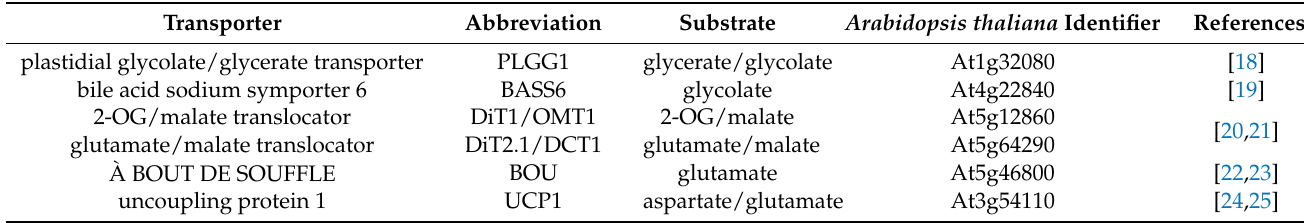
Table 1. List of identified PR transporters in Arabidopsis